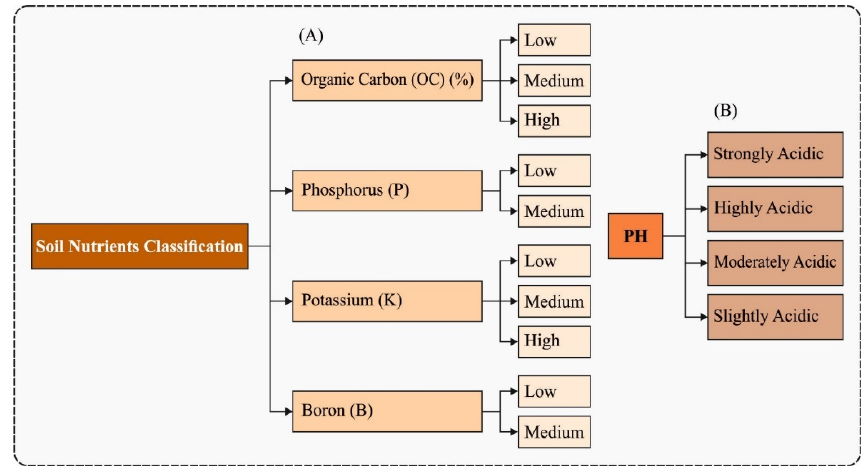
Figure 2. Parameters involved in the soil data ( A ) Soil Nutrients ( B ) Soil pH.